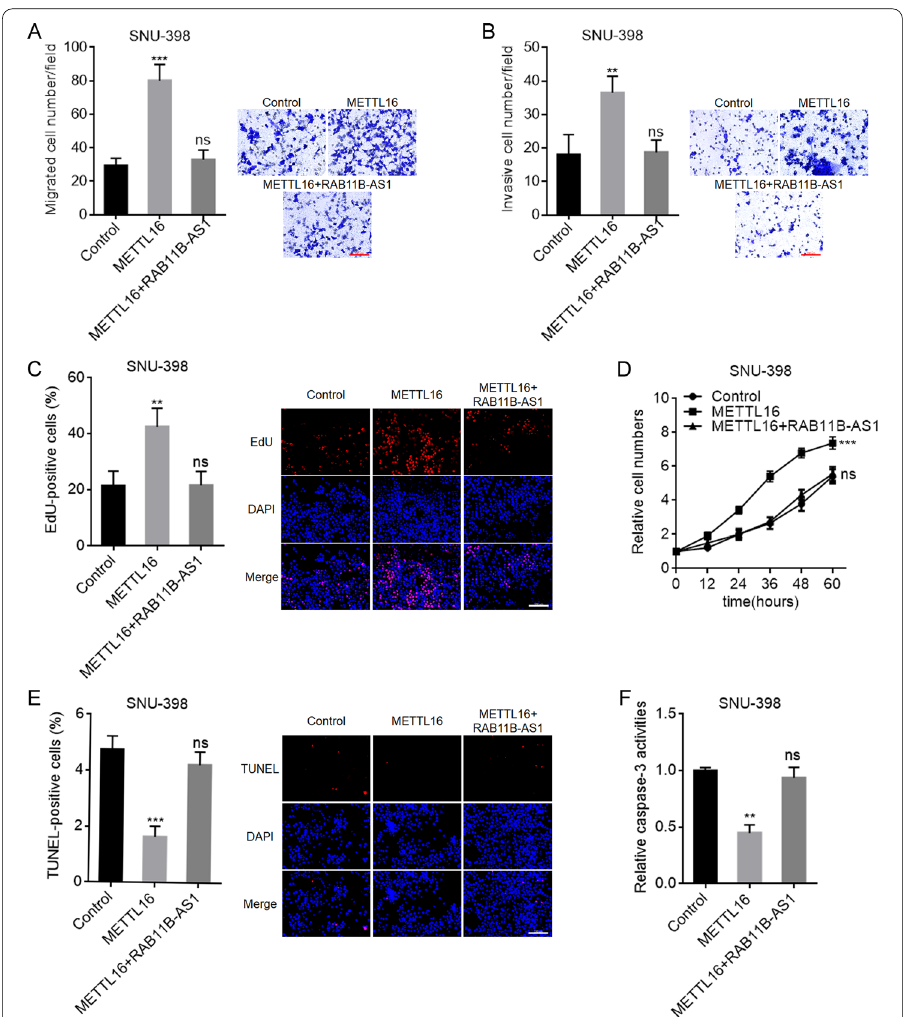
Fig. 8 RAB11B‑AS1 reverses the oncogenic roles of METTL16 in HCC. A Migration ability of SNU‑398 cells with METTL16 and RAB11B‑AS1 concurrent overexpression or control was detected by transwell migration assay. Scale bars, 100 µm. B Invasion ability of SNU‑398 cells with METTL16 and RAB11B‑AS1 concurrent overexpression or control was detected by transwell invasion assay. Scale bars, 100 µm. C Cellular proliferation of SNU‑398 cells with METTL16 and RAB11B‑AS1 concurrent overexpression or control was detected by EdU assay. Scale bars, 100 µm. D Cellular proliferation of SNU‑398 cells with METTL16 and RAB11B‑AS1 concurrent overexpression or control was detected by CCK‑8 assay. E Cellular apoptosis of SNU‑398 cells with METTL16 and RAB11B‑AS1 concurrent overexpression or control was detected by TUNEL assay. Scale bars, 100 µm. F Cellular apoptosis of SNU‑398 cells with METTL16 and RAB11B‑AS1 concurrent overexpression or control was detected by caspase‑3 activity assay. Results are shown as mean SD of n 3 independent experiments. ± = ** P < 0.01, *** P < 0.001; ns, not significant, by one‑way ANOVA followed by Dunnett’s multiple comparisons